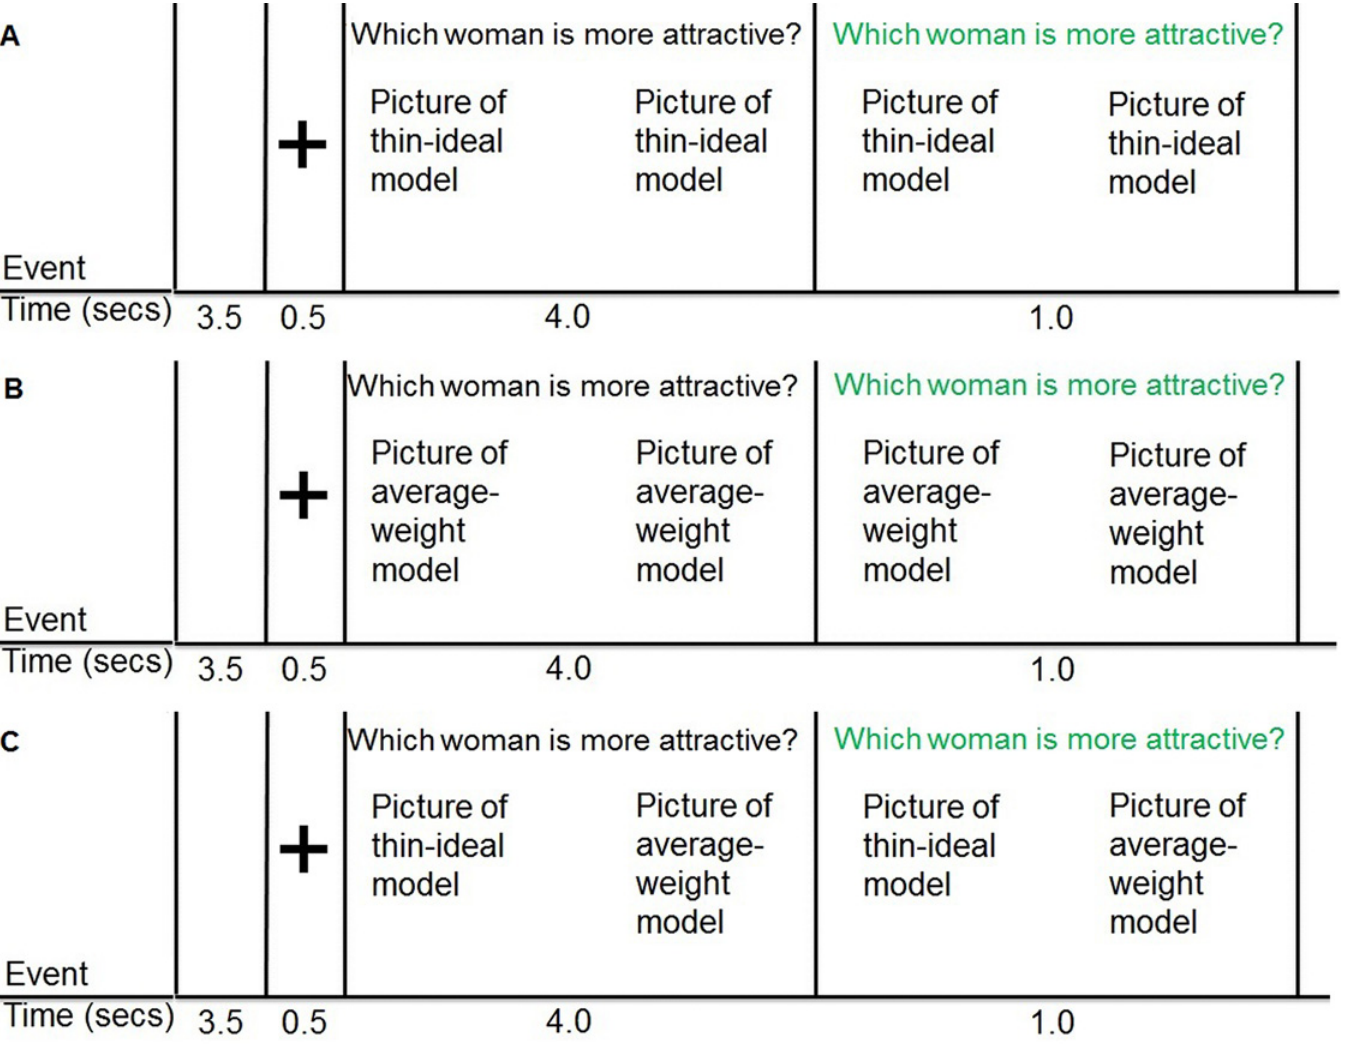
Fig 1. An illustration of the timing and ordering of our event-related thin image paradigm with the presentation of a) two thin-ideal models, b) two average-weight models, and c) one thin-ideal model and one average-weight